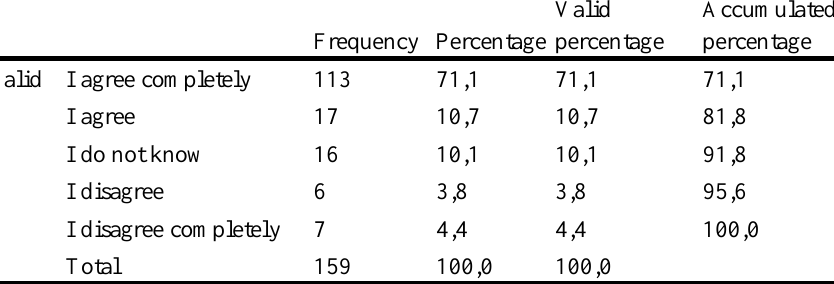
Valid percentage questionnaires´ results, question 5 “Students value the possibility of practising English at home with their parents”.